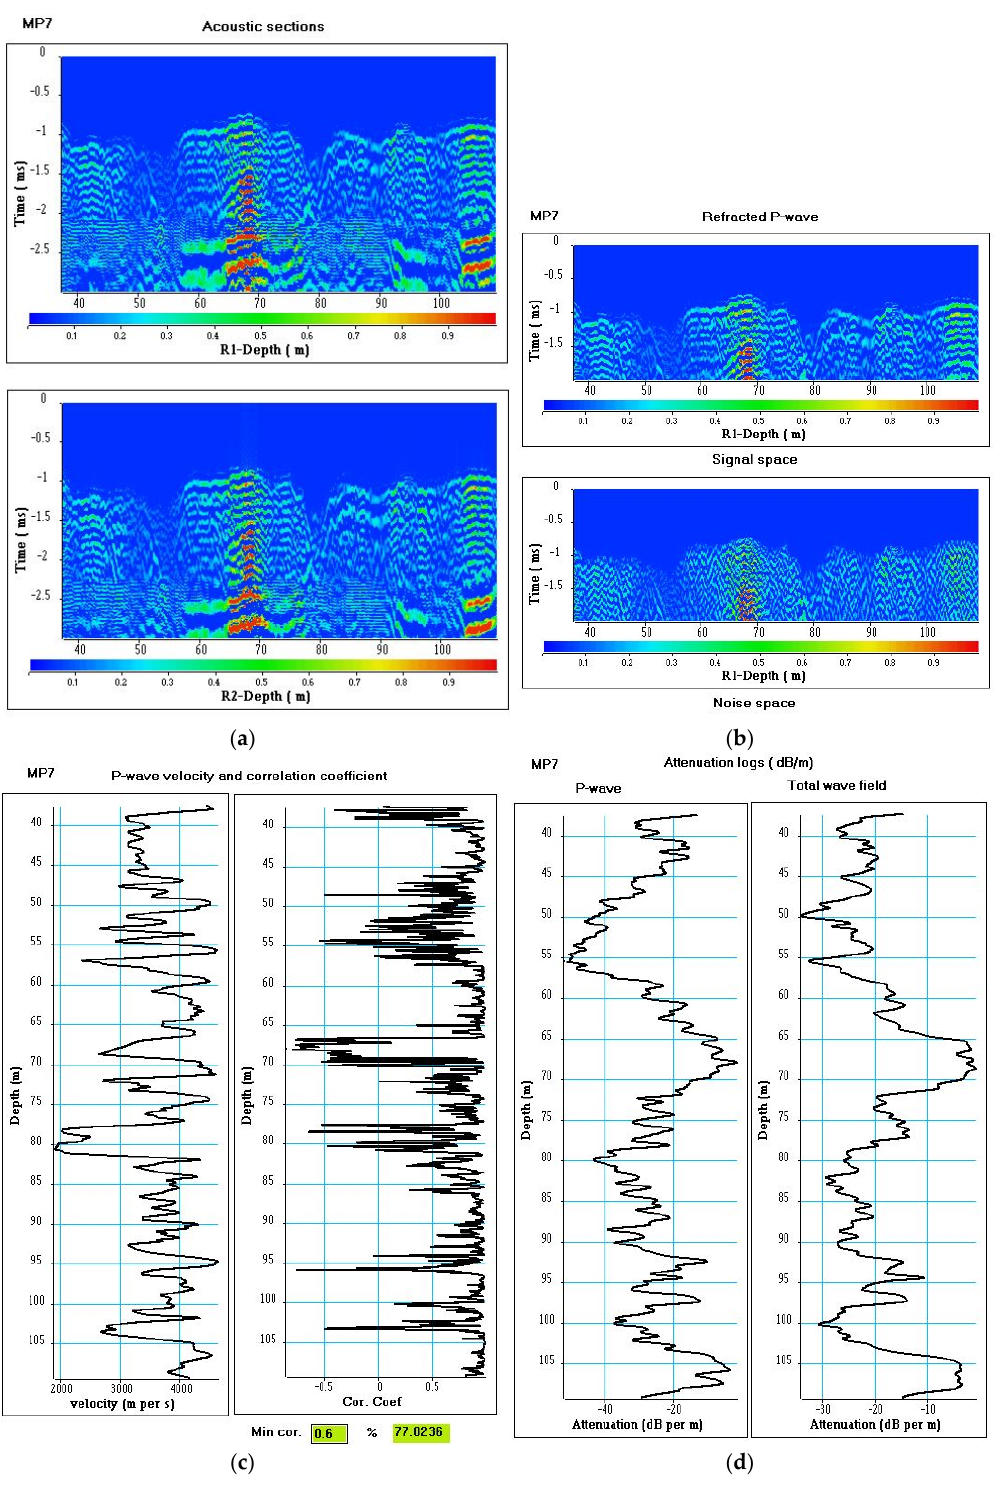
Figure 15. Refracted P ‐ wave ( a ) acoustic sections after mute. Vertical axis: recording time in ms, horizontal axis: depth of receiver R1 or R2, color scale: normalized amplitude. ( b ) Signal and noise space sections. ( c ) P ‐ wave velocity log and its associated correlation coefficient log, ( d ) P ‐ wave attenuation log, total wave attenuation log.